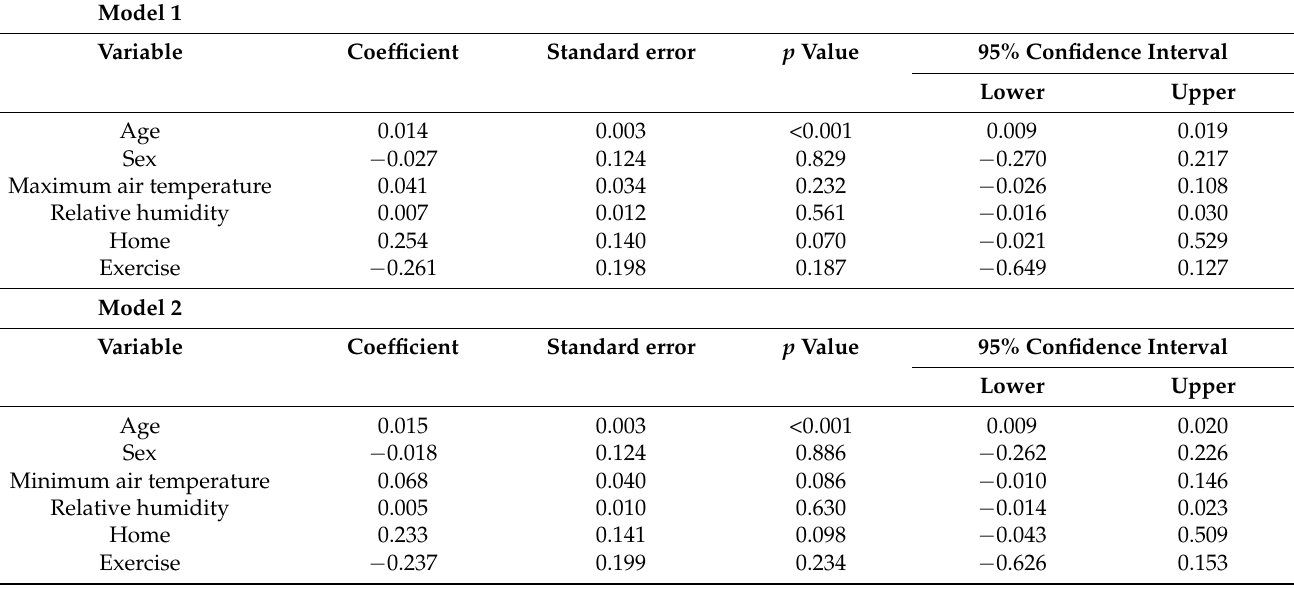
Table 5. Ordered logistic regression factors affecting the severity of a heat